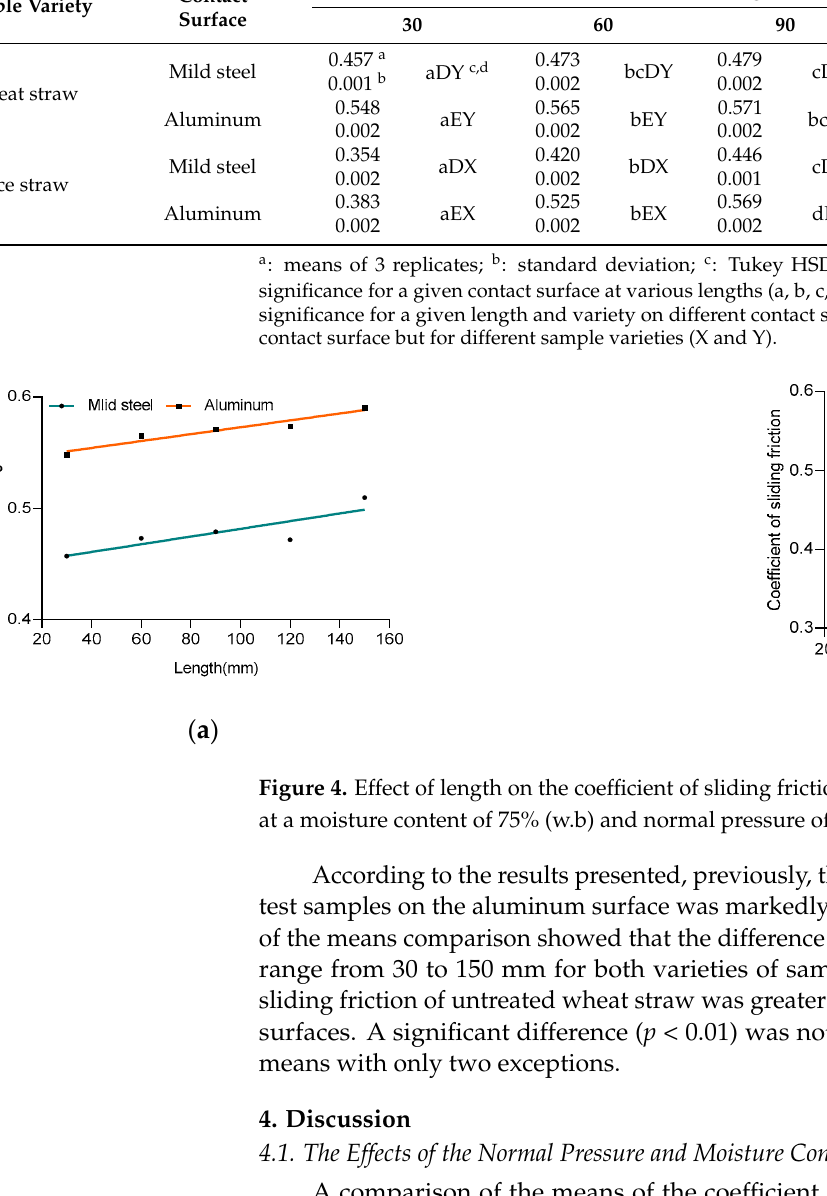
Table 7. Comparison of the coefficients of sliding friction between untreated and extrusion- exploded straw, wheat straw and rice straw, and mild steel and aluminum surfaces.